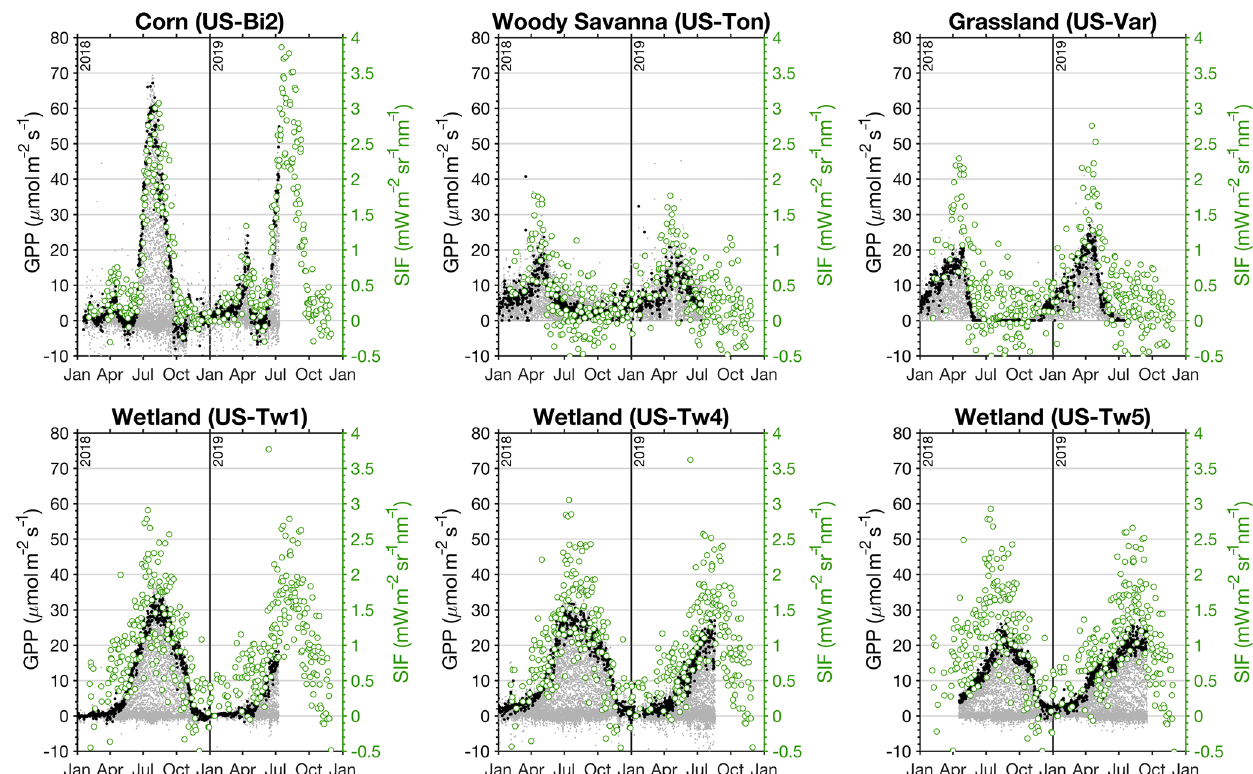
Figure 5. AmeriFlux GPP and TROPOMI SIF at six sites in California. Left axes (black) show GPP from AmeriFlux and right axes (green) show SIF values from TROPOMI that have been downscaled with NIR v . Light gray dots show all of the GPP measurements from the Amer- iFlux site and black dots indicate GPP measurements between 13:00 and 14:00PST (TROPOMI equatorial overpass is 13:30LST). Green circles show the TROPOMI SIF observations at the AmeriFlux sites after applying the scene-specific relative weighting from the MODIS NIR v . The AmeriFlux sites used are Bouldin Island (US-Bi2; 38.1090 ◦ N, 121.5350 ◦ W), Tonzi Ranch (US-Ton; 38.4316 ◦ N, 120.9660 ◦ W), Vaira Ranch (US-Var; 38.4133 ◦ N, 120.9507 ◦ W), Twitchell Island West Pond (US-Tw1; 38.1074 ◦ N, 121.6469 ◦ W), Twitchell Island East End (US-Tw4; 38.1030 ◦ N, 121.6414 ◦ W), and Twitchell Island East Pond (US-Tw5; 38.1072 ◦ N, 121.6426 ◦ W). CO 2 flux measurements and comparisons for other sites listed in Table 1 are shown in Figs. S3 and